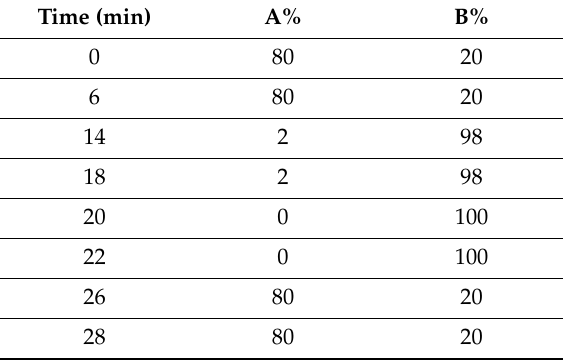
Table 4. Elution